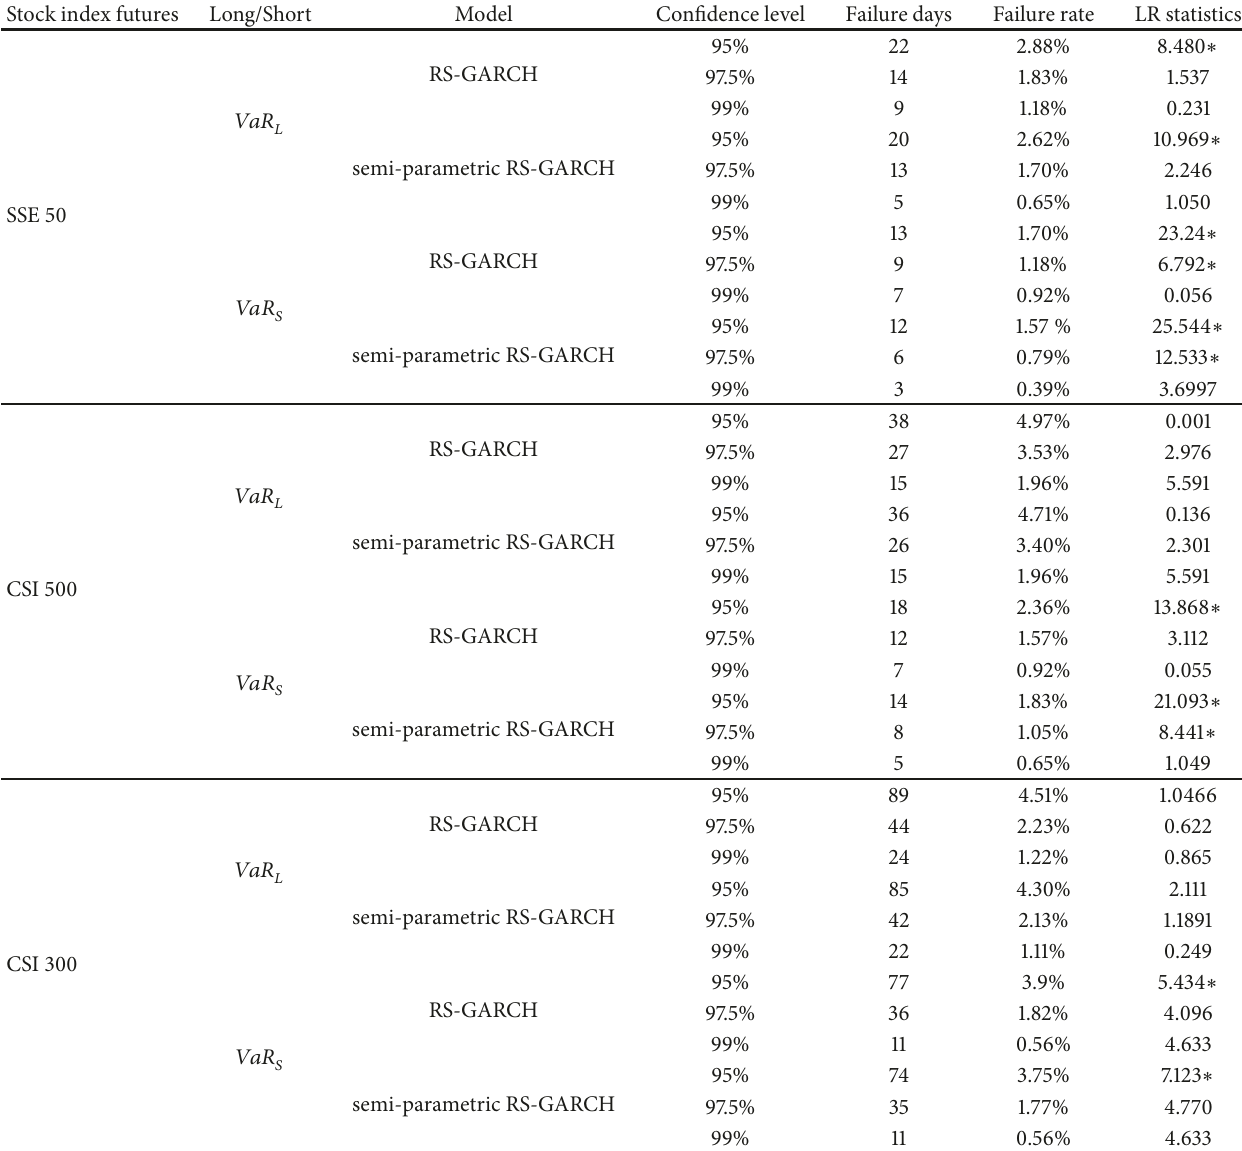
Table 10: The Kupiec backtesting of VaR of the basis for stock index